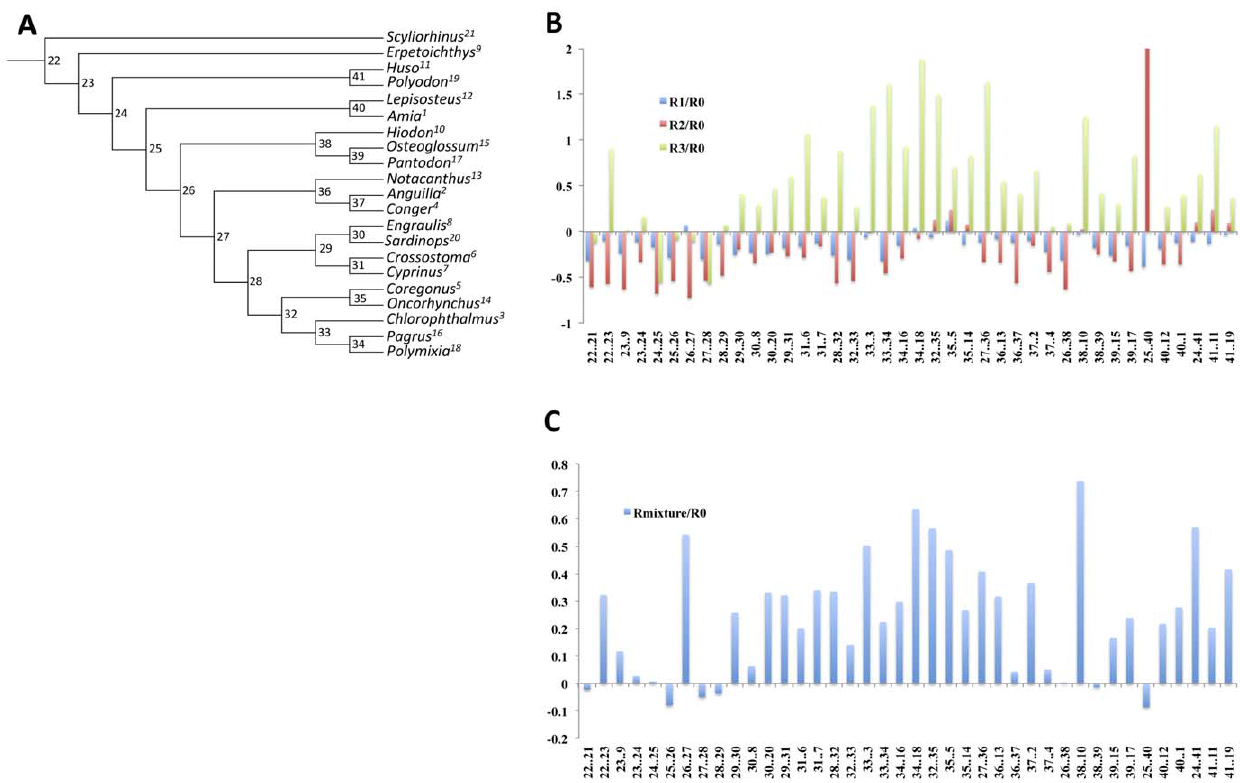
Figure 6. Comparison of branch lengths estimated under group-specific matrices and an overall matrix. Reduced datasets were used to investigate the impact of model-choice on branch lengths. A . A phylogenetic tree for 21 fish taxa. B . A plot showing differences between branch lengths estimated under partition-specific matrices and the mtFishR0 matrix. C . A plot showing the differences between the corrected branch lengths under a mixture of the partition specific matrices and mtFishR0 for the whole data. Differences between branch lengths (Bl) are measured as (Bl_ R i / Bl_ R 0 ) – 1, where Bl_ R i denotes branch lengths obtained using a partition specific matrix, and Bl_ R 0 denotes branch lengths obtained using the reference matrix (mtFishR0). This measure centers the difference between branch lengths on 0, with values above 0 indicating branches that were larger under the partition-specific matrix and values below 0 indicating branches that were shorter under the partition-specific matrix. A value of zero indicates no difference between branch